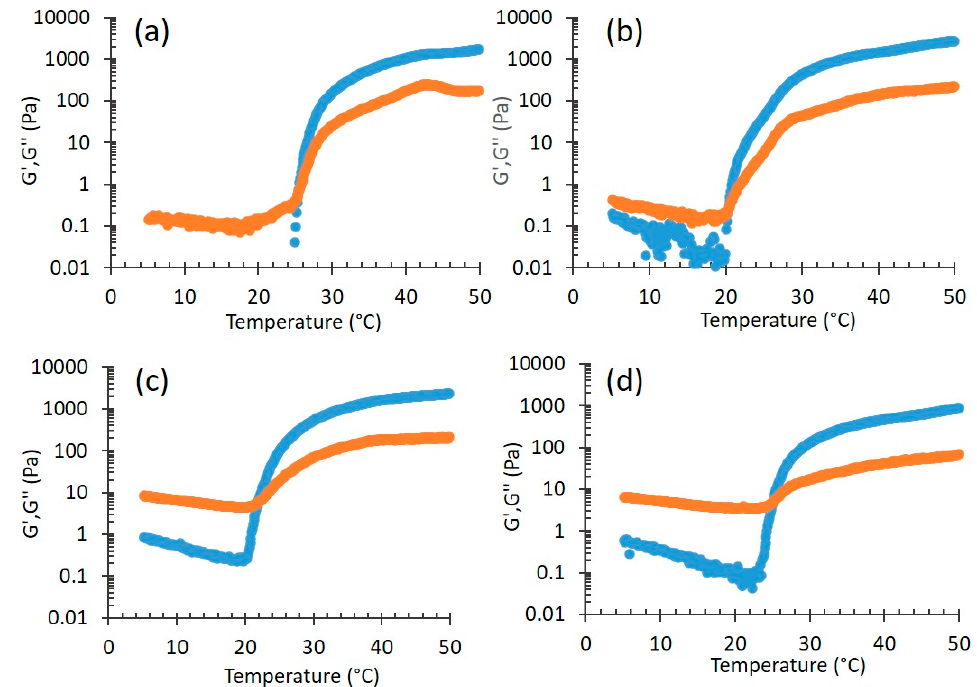
Figure 5. Temperature effect on elastic (G', blue) and viscous (G'', orange) moduli for P ( a ); P-CA ( b ); P-HA ( c ); and P-HA-CA ( d ).